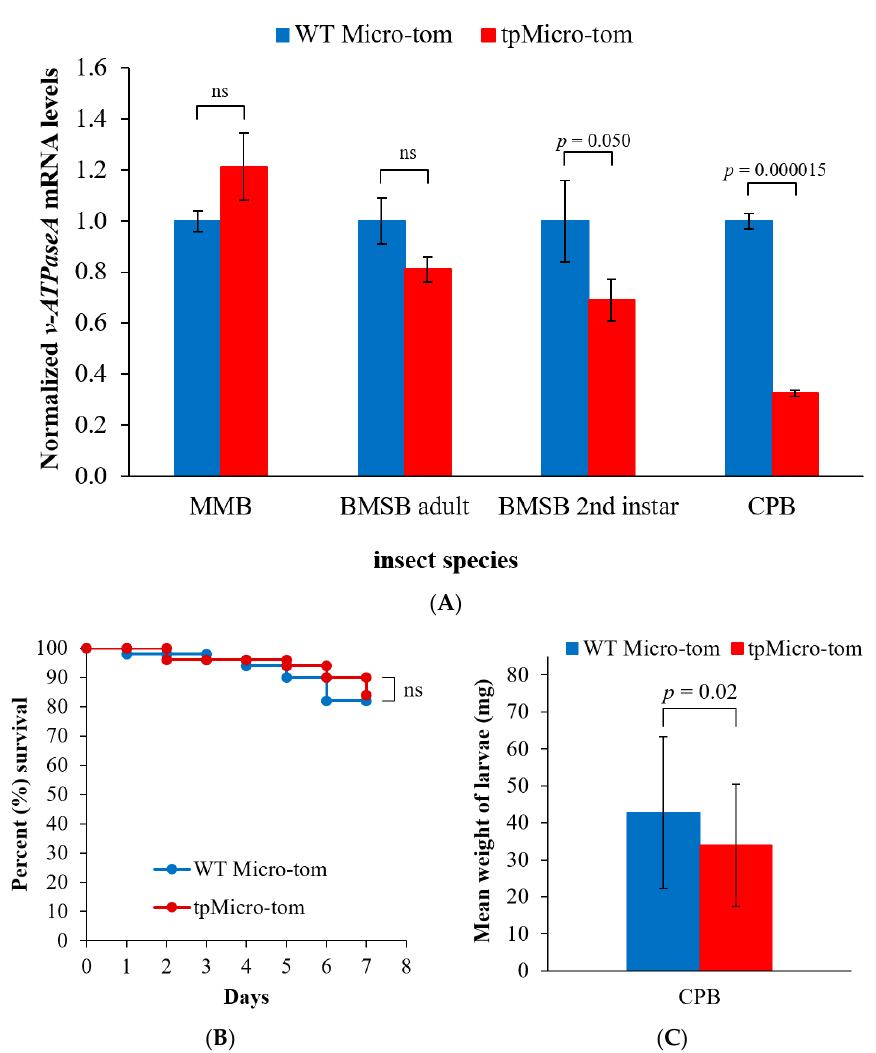
Figure 4. Normalized relative v-ATPaseA mRNA levels in different insect species after feeding on plastid-produced dsRNA, and survival and weight analysis for CPB. ( A ) mRNA levels for MMB adults, BMSB adults, BMSB 2nd instar larvae, and CPB 1st instar larvae. mRNA levels in WT Micro-tom-fed insects were set to the value “1.0”, and mRNA levels in tpMicro-tom-fed insects were calculated relative to the WT Micro-tom-fed insects. Reference genes used were betaTUB for MMB, 60S RP for BMSB, and RPL8E for CPB. Data are expressed as mean relative quantity ± SEM, n = 3, and two-sample t -tests were used to determine p -values which are indicated on the graph. MMB = Madeira mealybug; BMSB = brown marmorated stink bug; CPB = Colorado potato beetle; “ns” = not significant ( p > 0.05) according to t -tests. ( B ) Kaplan–Meier survival analysis for CPB larvae after 7 days of feeding on WT Micro-tom or tpMicro-tom. “ns” = not significant ( p > 0.05) according to Log-rank post hoc analysis. ( C ) Mean weight of CPB larvae after feeding on WT Micro-tom or tpMicro-tom. Data are expressed as mean weight ± SD; n = 50. Two sample t -test was used to determine p -value which is shown on the